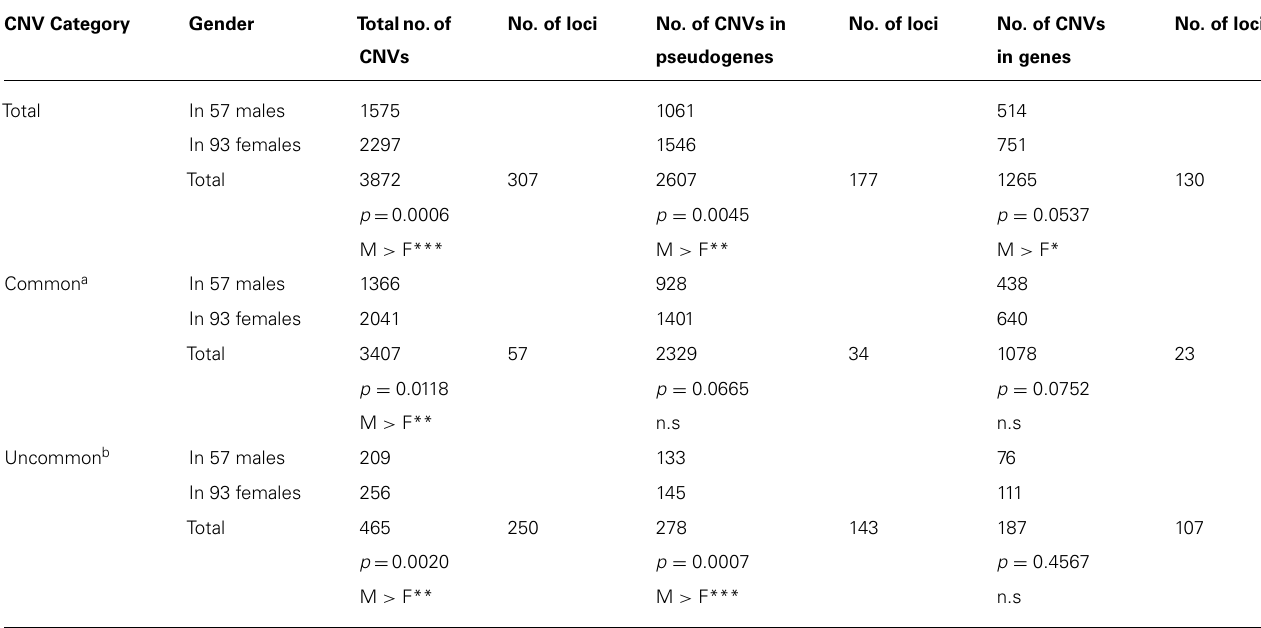
Table 1 | Gender comparisons of the number of common and uncommon CNV variants among OR genes and